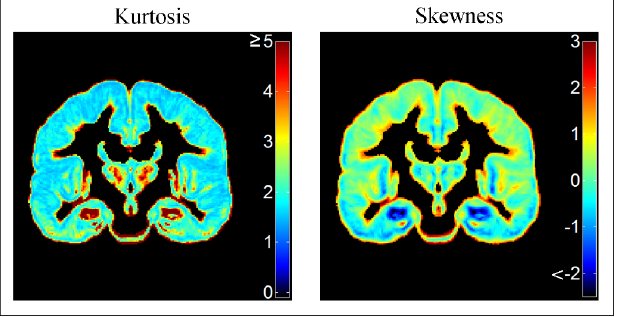
Fig 7. Voxel-wise kurtosis and skewness in the grey matter proportion atlas subjects (n = 98). The Gaussian distribution has kurtosis of 3 (yellow on the left panel) and skewness of 0 (light green on the right